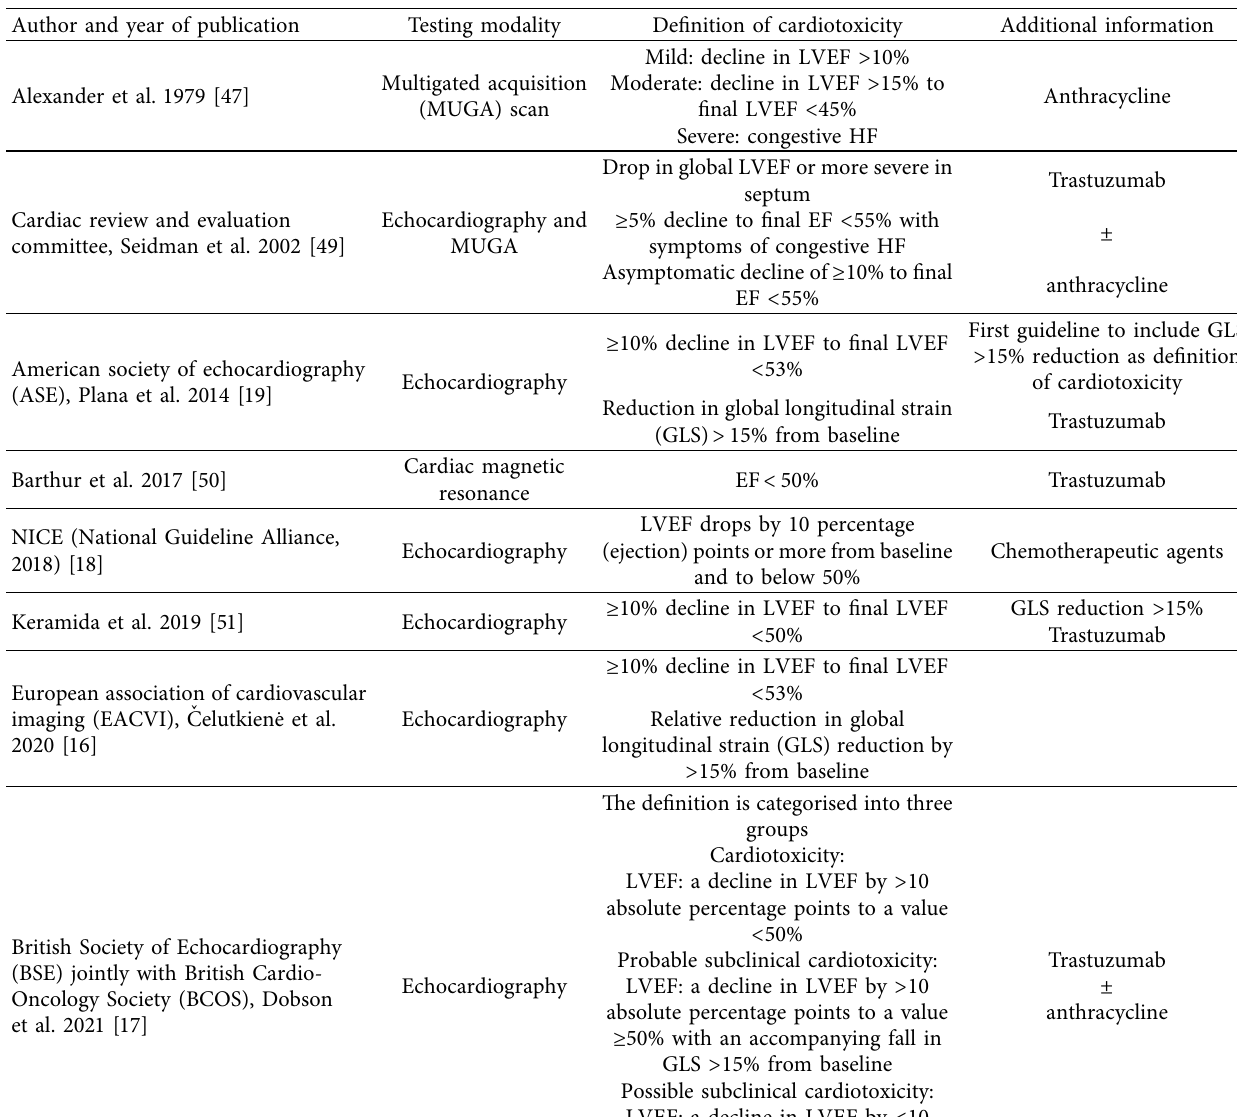
Table 2: Definitions of